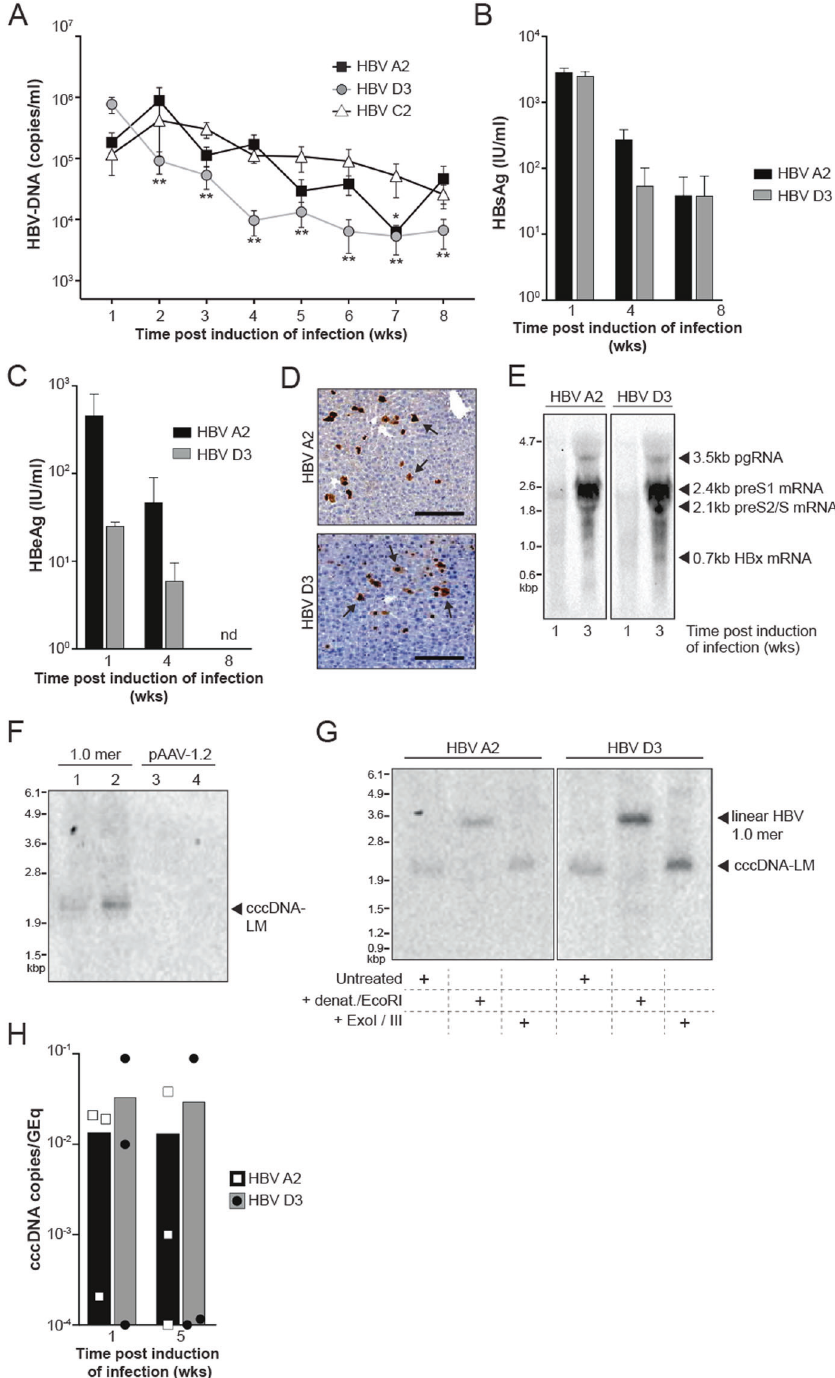
transfected HepG2 cells (Fig. 1I). cccDNA like molecules were detectable for at least 7 days in HepG2 cells transfected with HBV 1.0 underscored the rationale for pursuing this method to establish cccDNA in vivo in